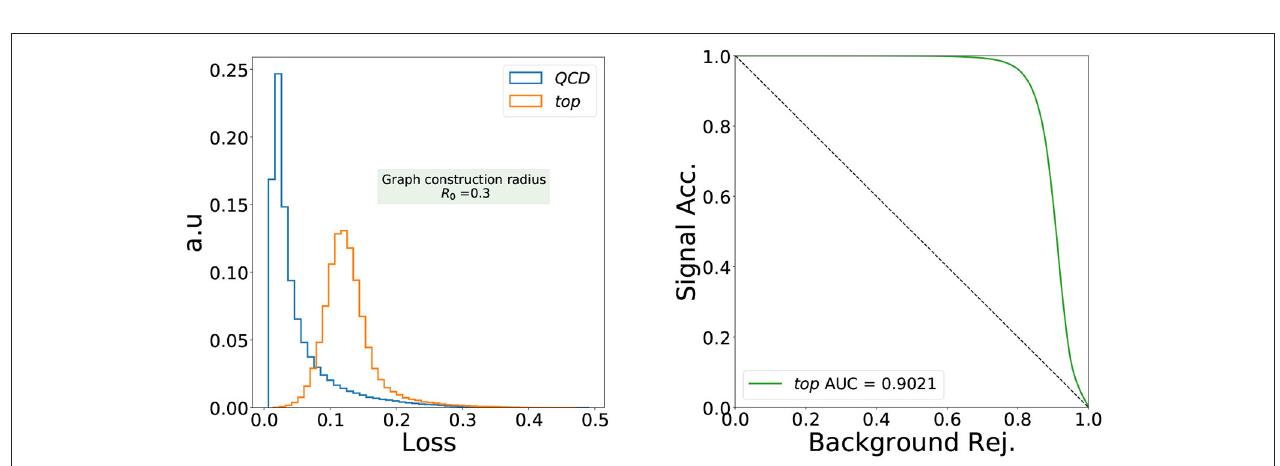
FIGURE 3 | The distribution of the loss function of an IRC safe graph autoencoder trained only with QCD jets with graph radius R 0 =